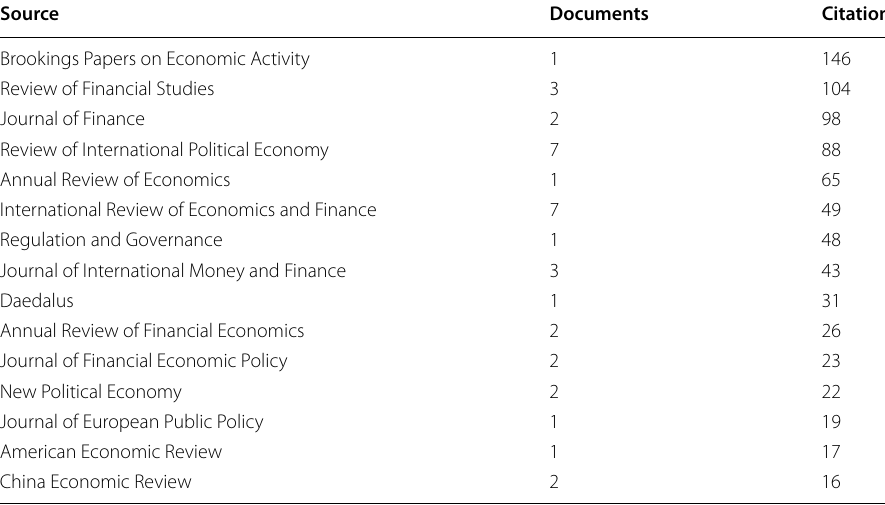
Table 3 Highest cited sources with corresponding number of